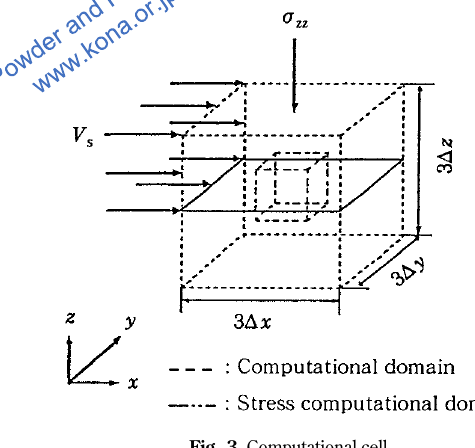
Fig. 3 . Computational